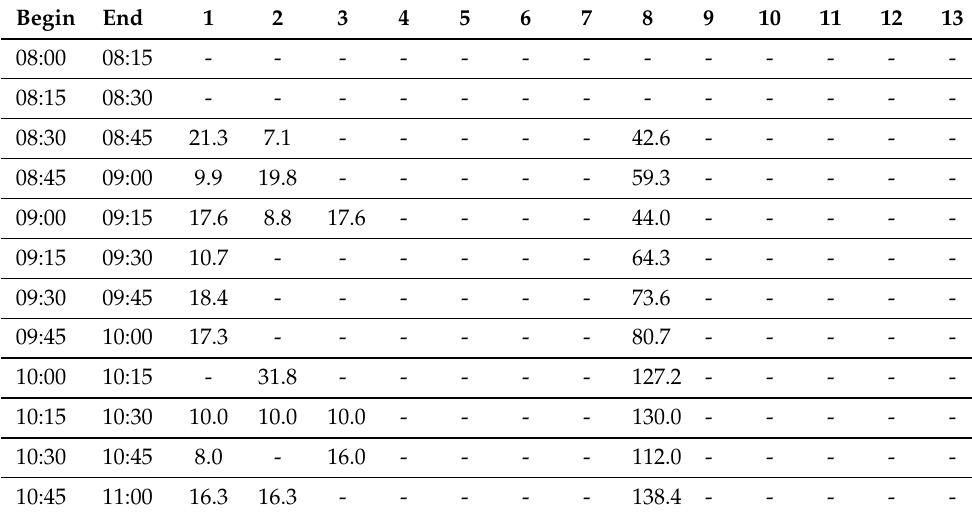
Table 9. Example of electricity consumption, in kWh, per choreography.